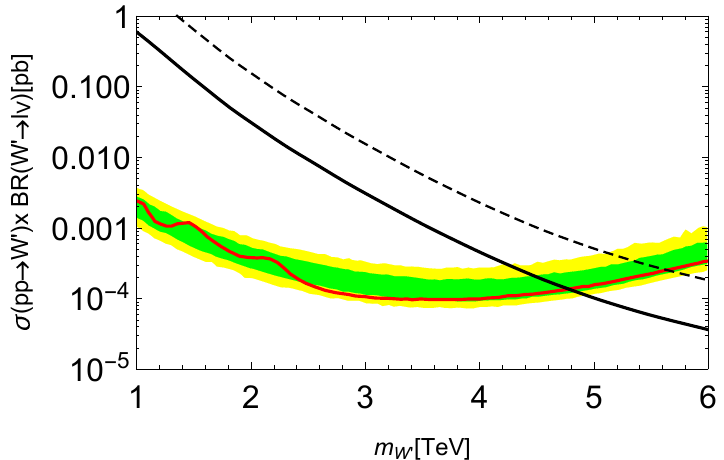
p =g = 1 = 5 (solid diagonal line), e(cid:11)